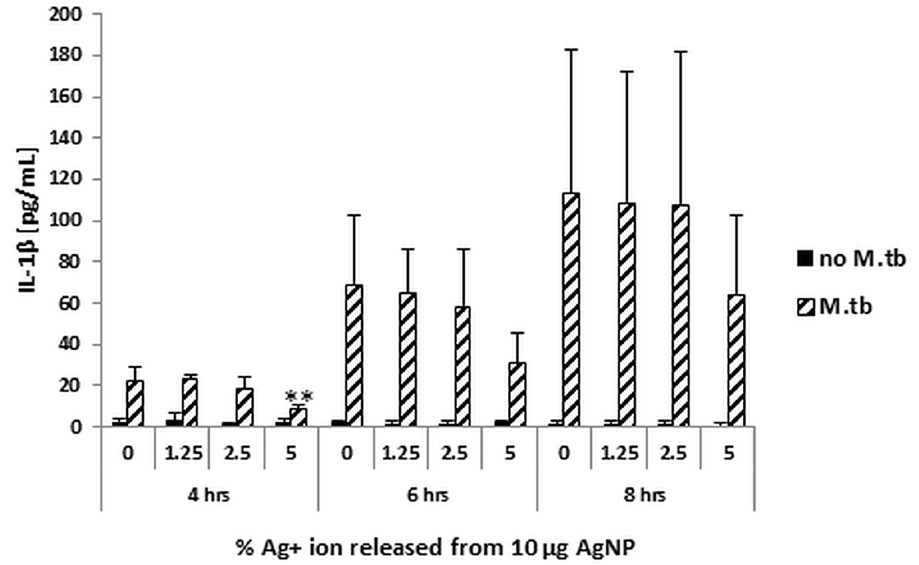
Fig 6. Effect of Ag + ions on M . tb -induced IL-1 β expression. MDM were exposed to AgNO 3 corresponding to 0.125, 0.25 and 0.5 μ g/mL of Ag + ions in the absence or presence of M . tb at MOI 10. Culture supernatants collected at 4, 6 and 8 hours after infection with M . tb ± Ag + ion exposures were assessed for IL-1 β production. Results are expressed as means ± SD from four independent experiments. Statistically significant changes relative to M . tb -exposed MDM (0 on X-axes) were determined by two-tailed unpaired t- test and marked by ** ( p <